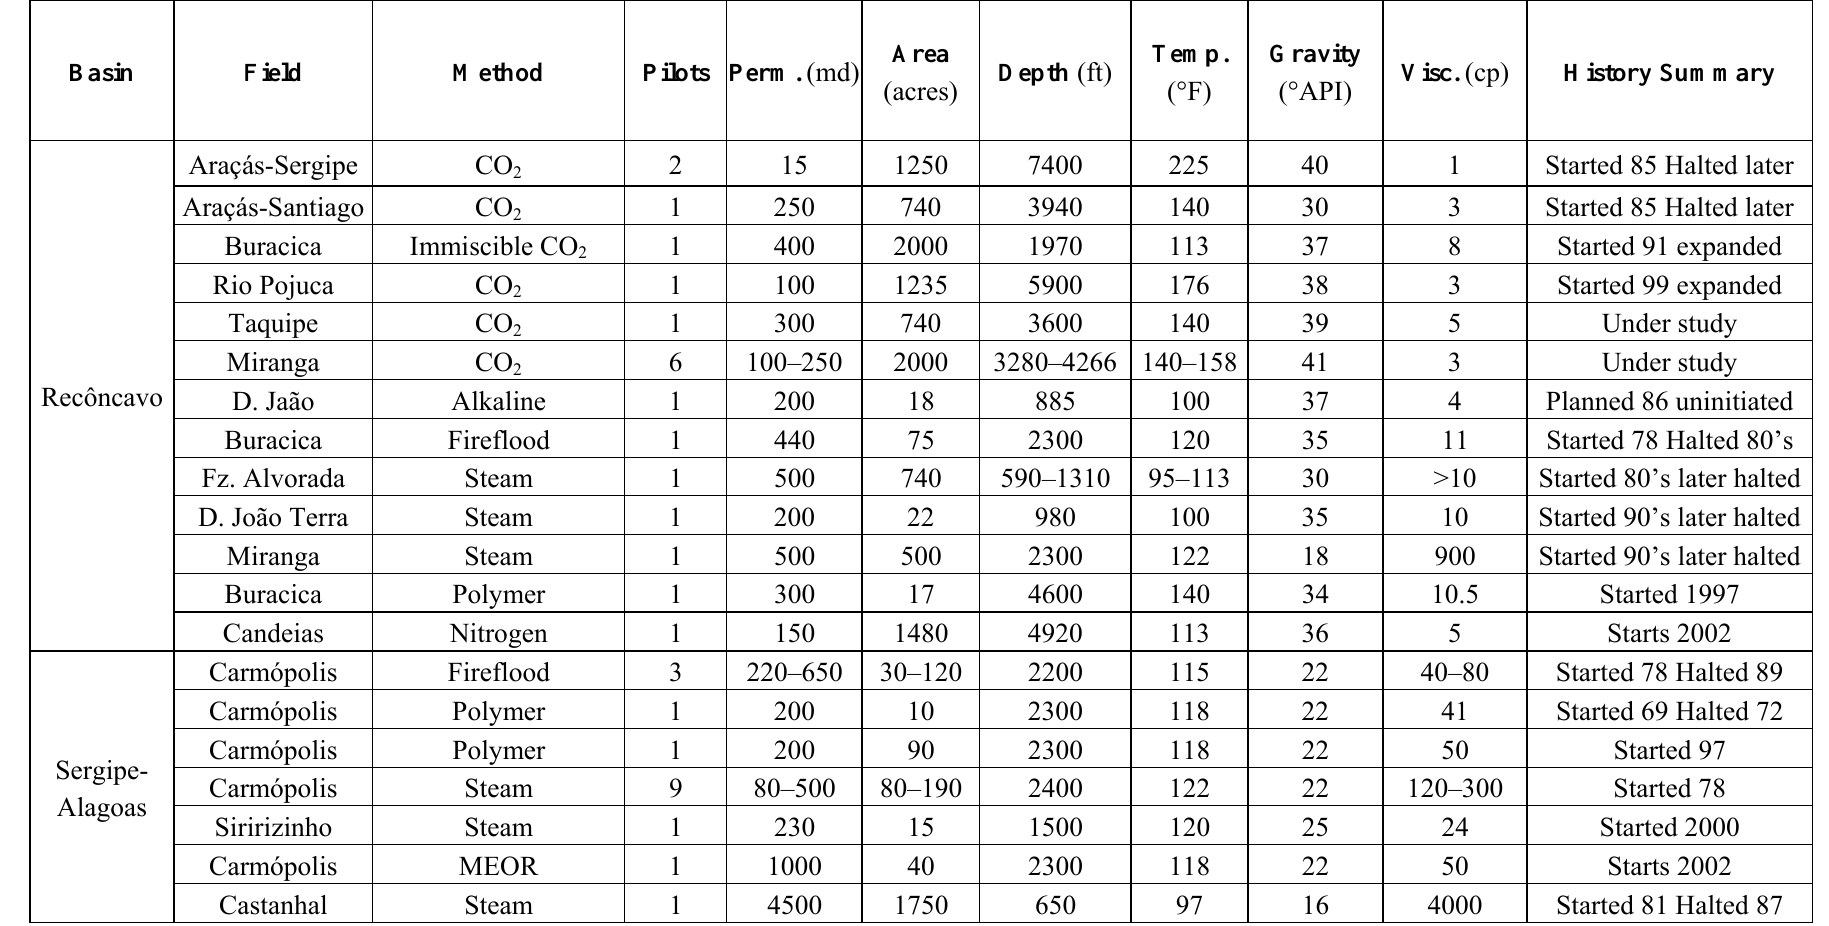
Table 1. Summary of IOR activities in Brazil